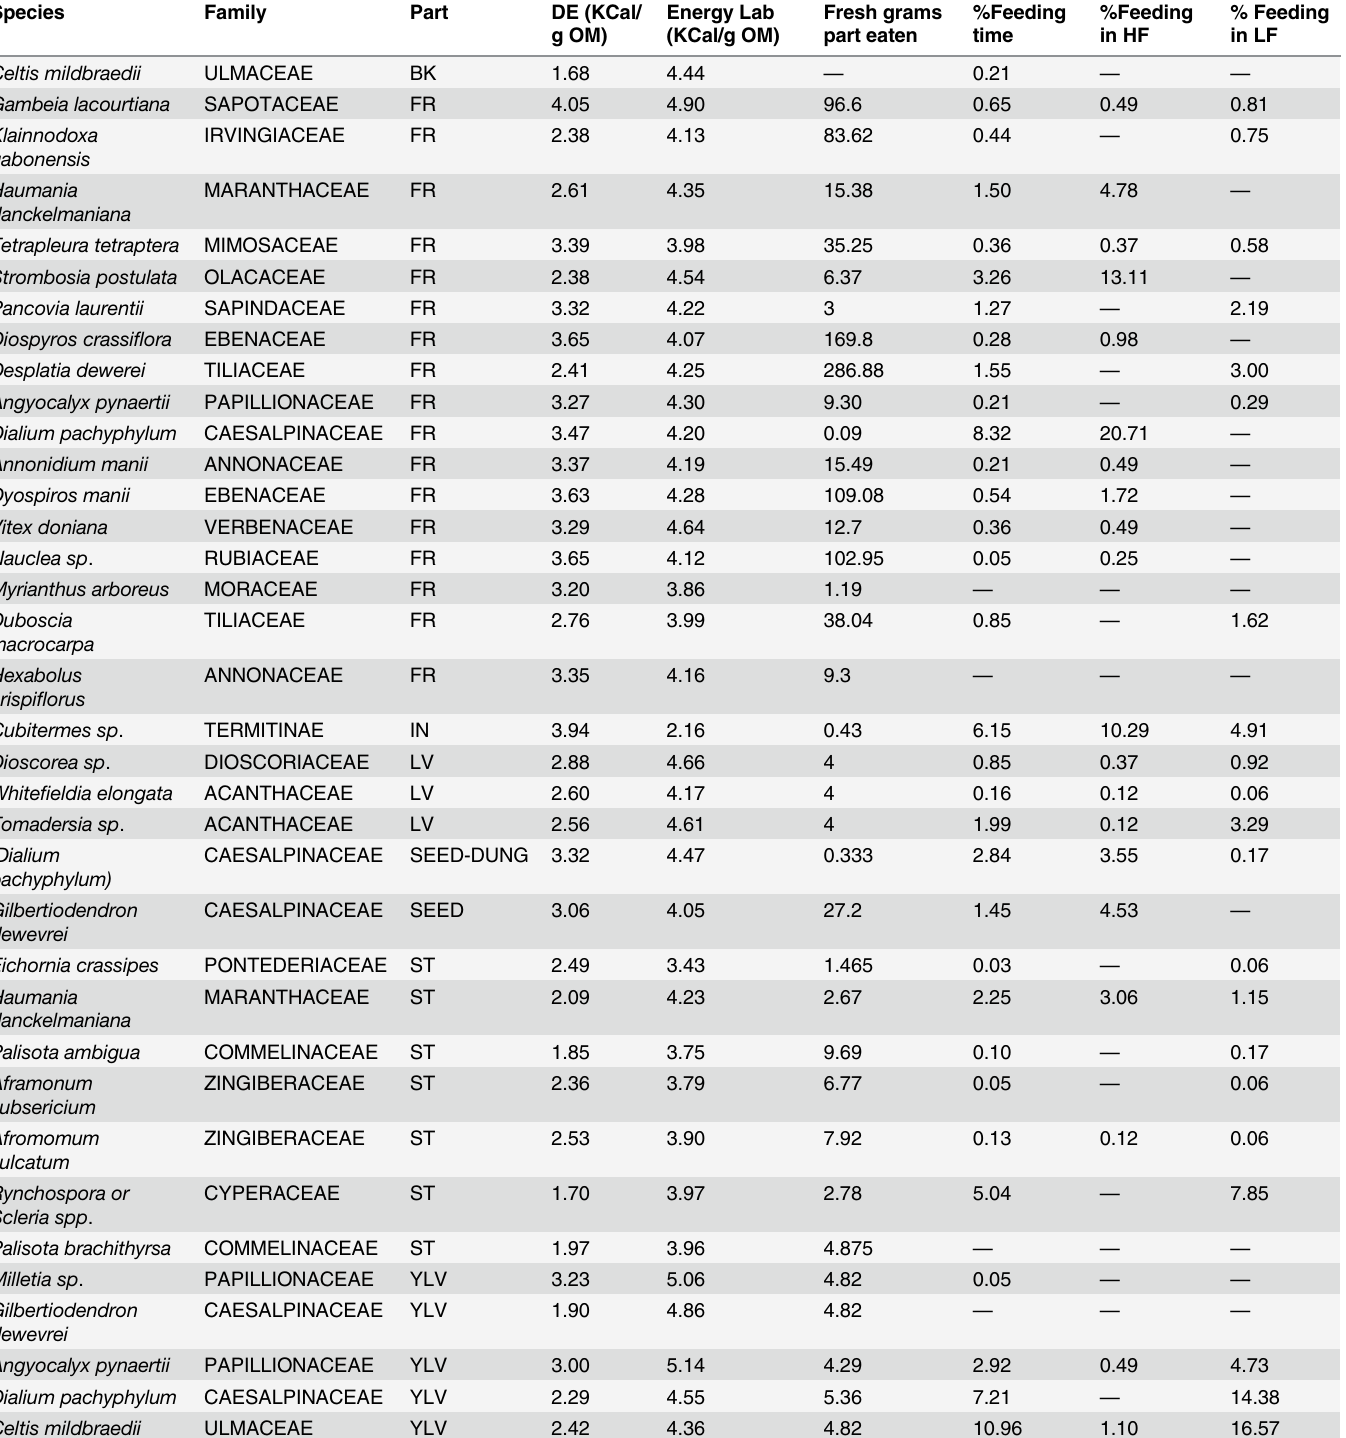
Table 1. Energy content of foods analysed, and relative time spent feeding on each food item in different seasons during this study.